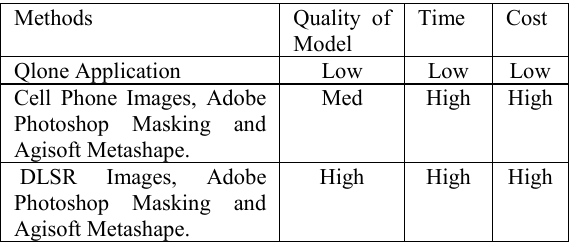
Table 1. Comparison of methods, based upon quality of model to time to